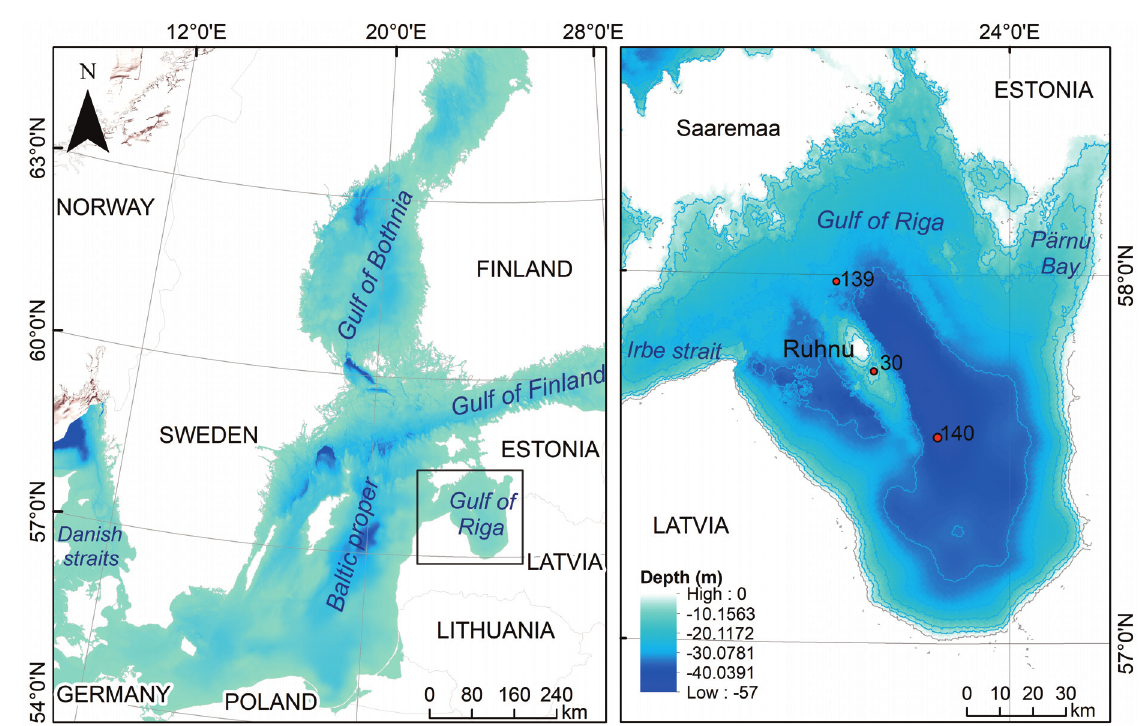
Fig. 1. The Gulf of Riga in the Baltic Sea (left panel) and the island of Ruhnu in the Gulf of Riga (right panel). The right panel shows the area covered by the second-level computational grid of the wave model and the selected grid points (30, 139, 140) for the analysis of wave directions. Point 30 is located at Gretagrund, a shallow area to the south of Ruhnu.